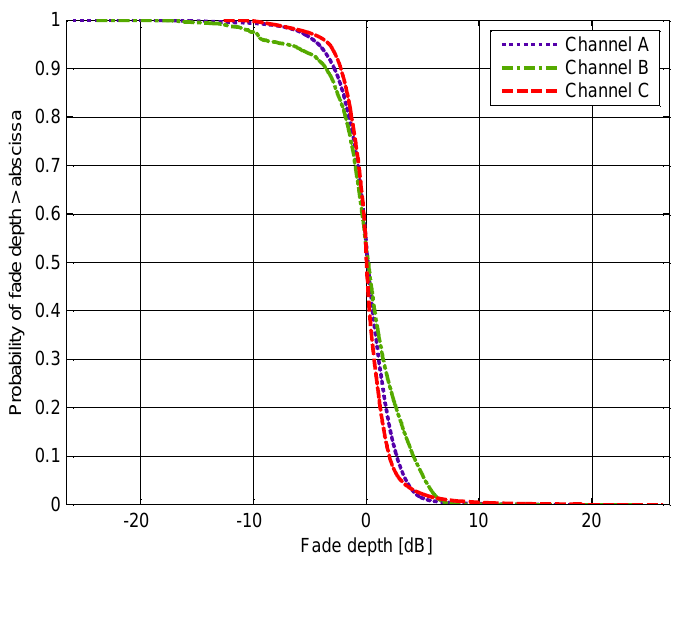
Figure 8. Complementary cumulative distribution functions of the fade